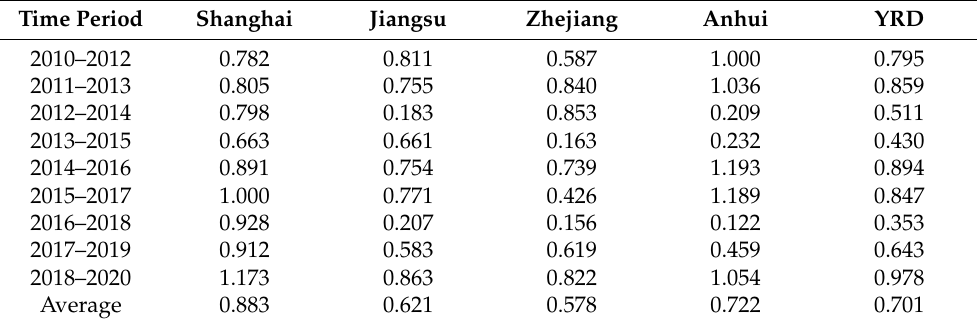
Table 6. Distribution of Overall Efficiency in high-tech Manufacturing Industry from 2010 to 2020. Time Period